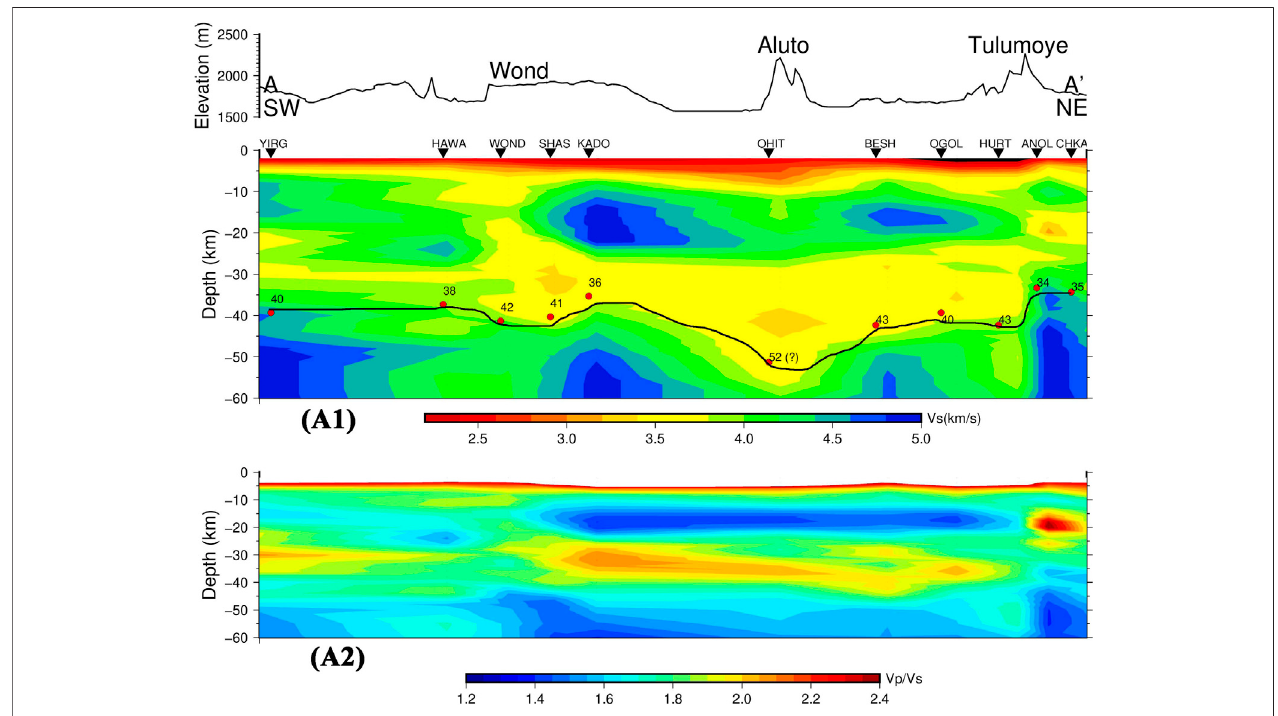
FIGURE 8 | (A1) shows a 2D vertical slice along the eastern margin of the central Main Ethiopian Rift, which is obtained from pro fi le AA ′ of Figure 1 covering from station YIRG (1,756 m) to CHKA (1,604 m). (A2) shows the Vp/Vs ratio values at various depth points. Red indicates slower velocity and blue faster velocity. B2 shows the values of Vp/Vs for the rift and the plateau side of the pro fi le. Blue indicates low Vp/Vs, and red indicates high Vp/Vs ratio.